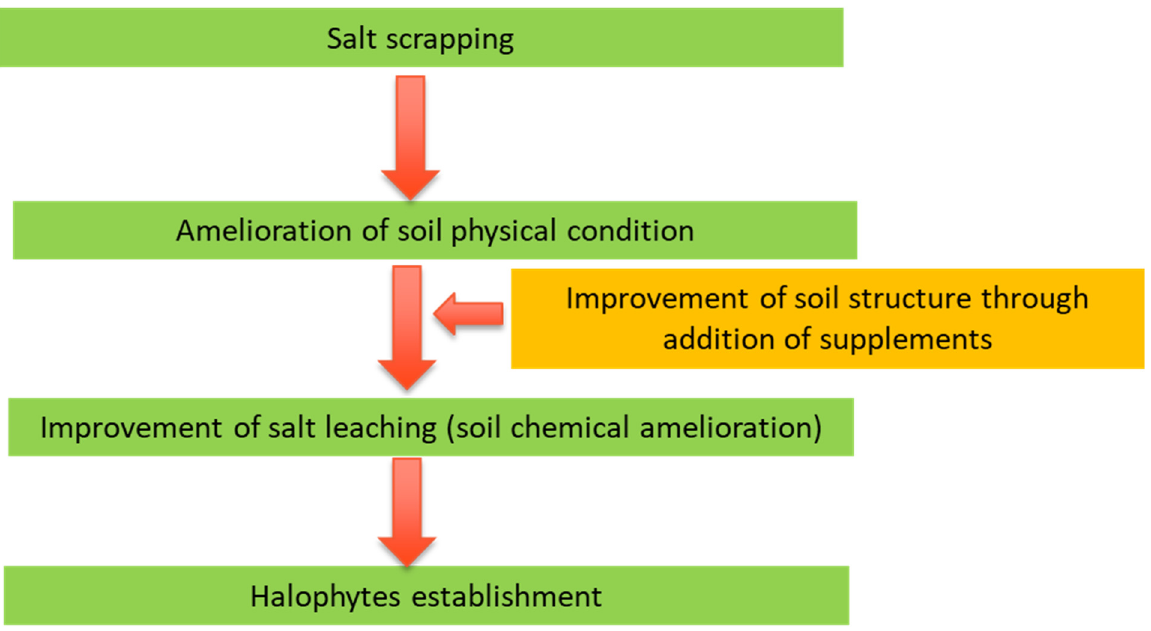
Figure 1. The diagram indicating the techniques required for reclamation of salt-affected land.